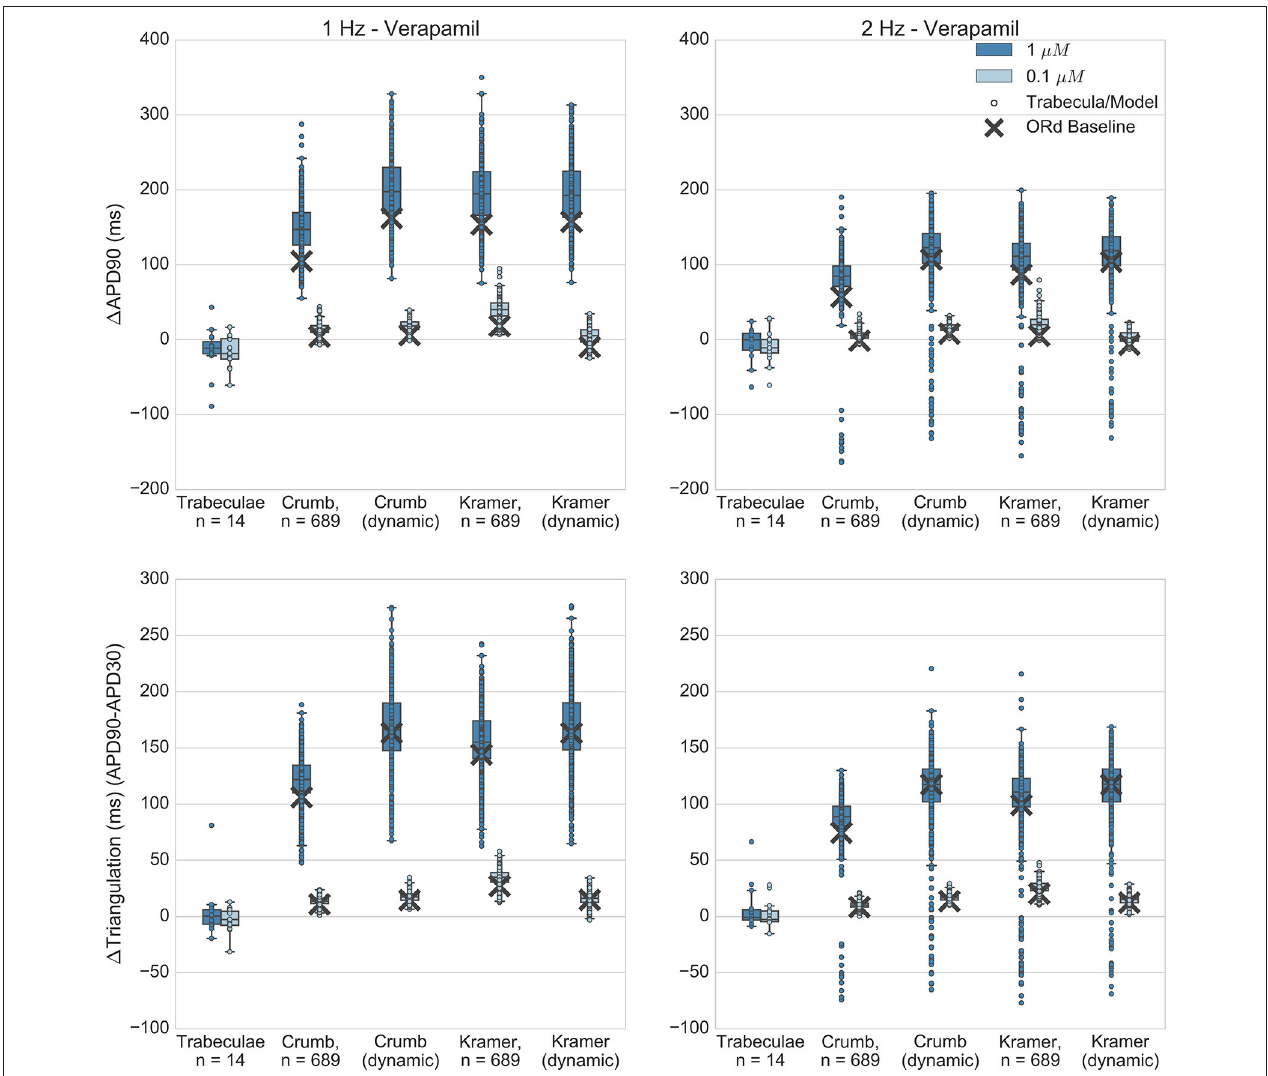
FIGURE 8 | Verapamil. Changes to APD90 and triangulation relative to control from application of 0.1 and 1 µ M verapamil during 1 and 2 Hz pacing. In each panel, response is shown for (left to right): human ventricular trabeculae, populations of models using drug effects calculated using data from Crumb et al.; from Crumb et al. with I Kr replaced by the Li et al. I Kr model; from Kramer et al. and from Kramer et al. with I Kr replaced by the Li et al. I Kr model. Dots indicate results from individual trabeculae and models, crosses show the result from the baseline ORd